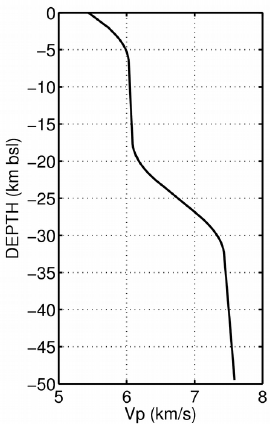
Figure 3 – The P­wave velocity model used for calculat­ ing theoretical travel times (after Carannante et al.,